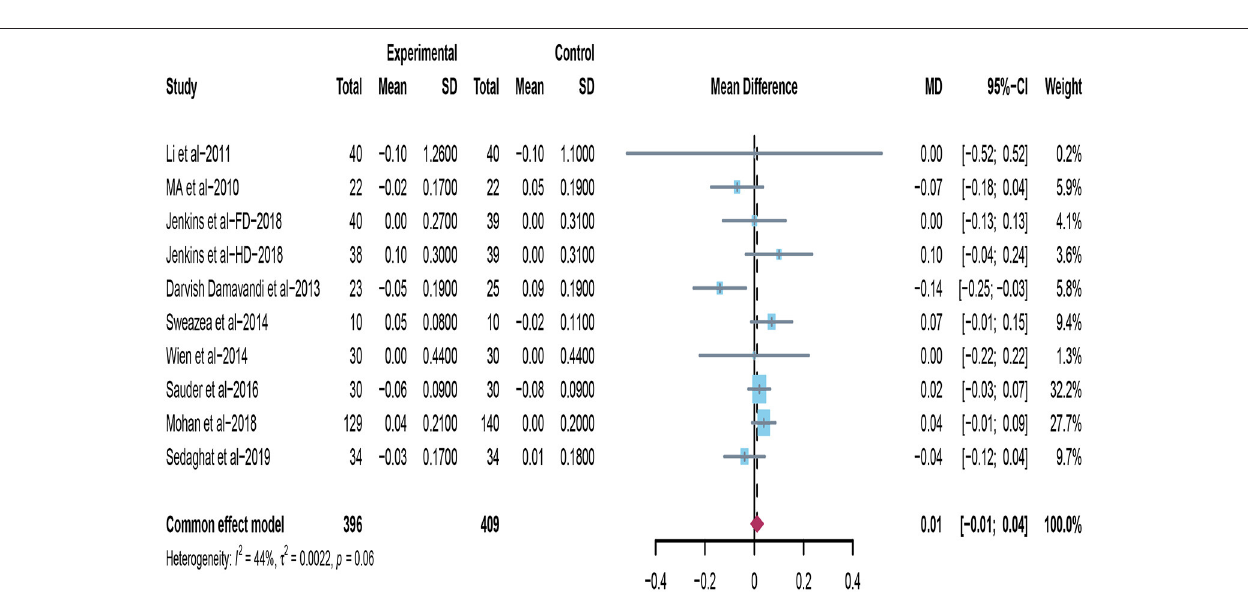
FIGURE 4 | Effect of peanuts and tree nuts supplementation on HDL-C (mmol/l) in patients with type 2 diabetes. HDL-C, high-density